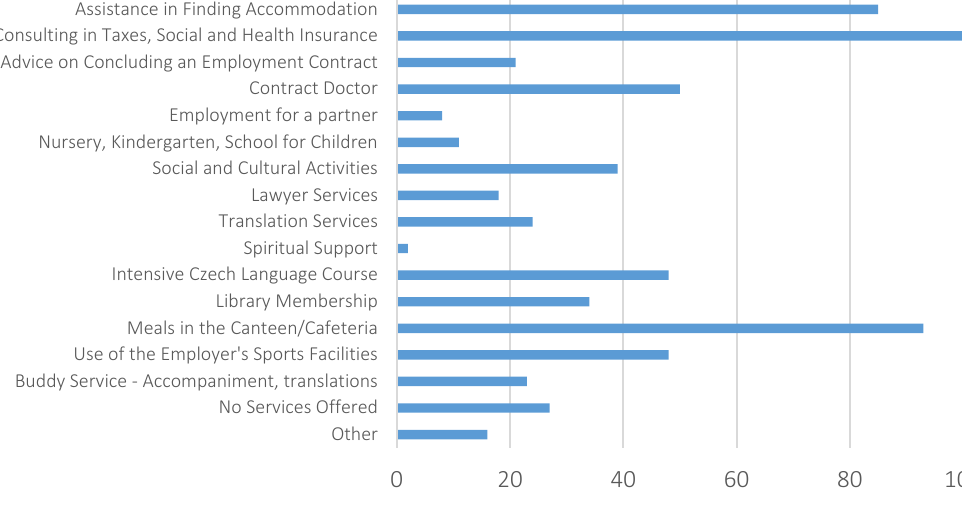
Figure 1. Types of services used